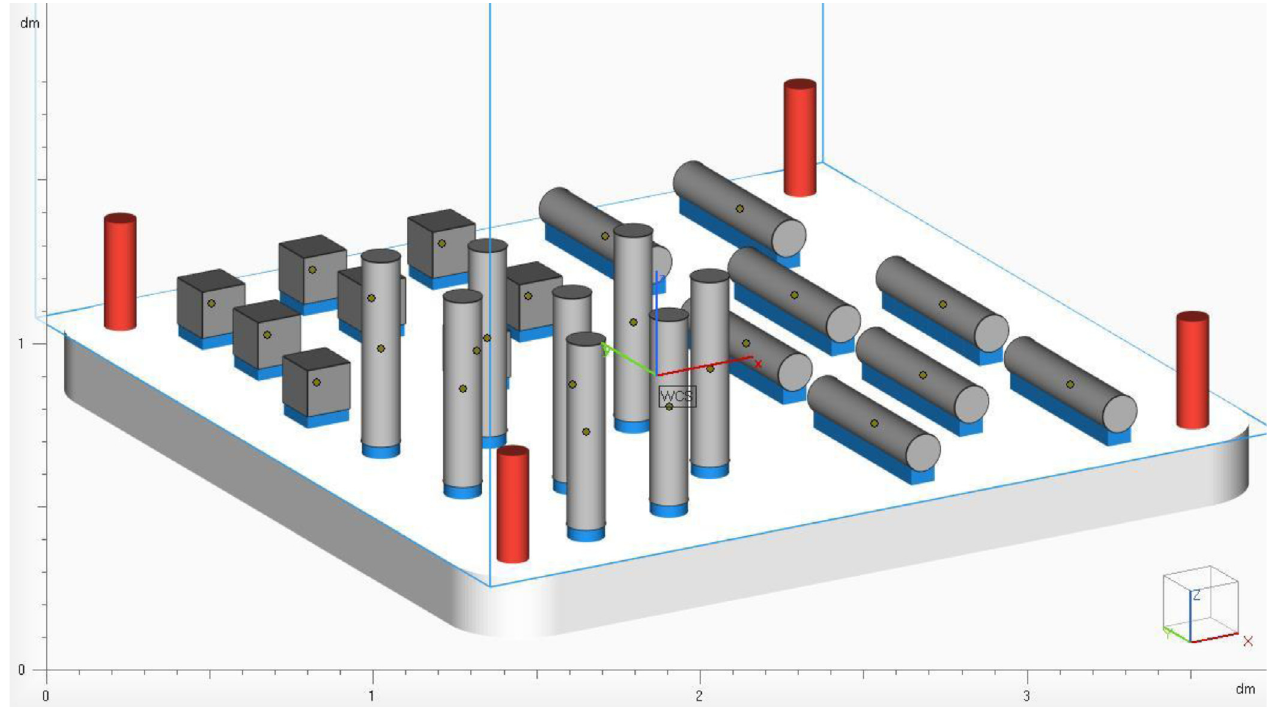
Fig. 1. Example of build platform based on the parameters de fi ned in Section